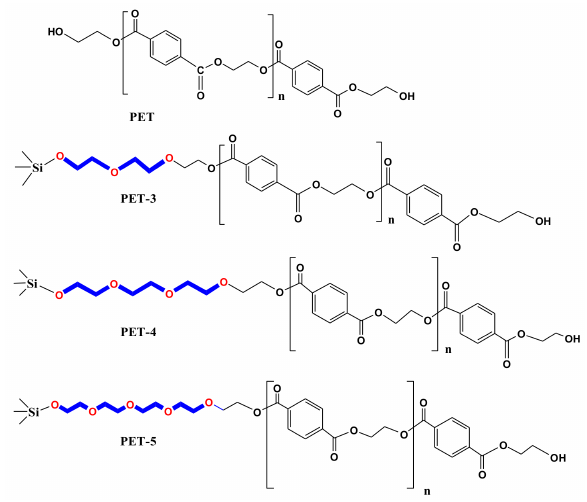
Figure 1. Chemical structures of PET, PET-3, PET-4 and PET-5.